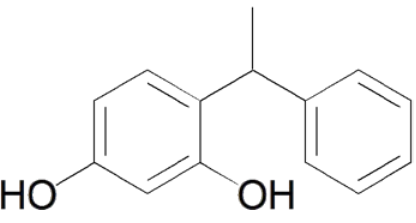
Figure 1. Structure of 4-(1-phenylethyl)1,3-benzenediol (PR).